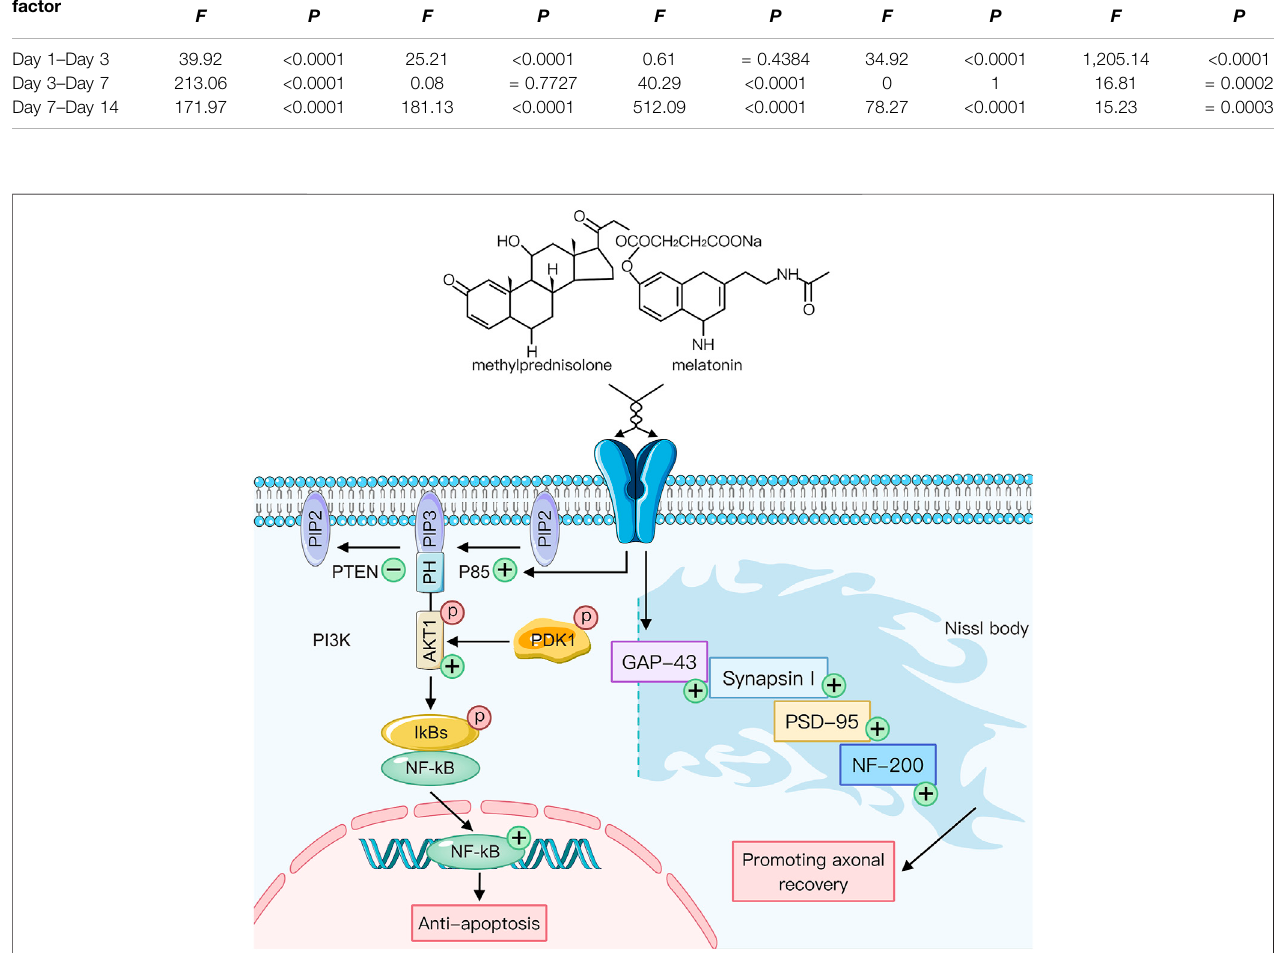
FIGURE 5 | The potential mechanism underlying the synergistic effect of melatonin and methylprednisolone in the stimulation ofkey axon proteins and inhibition of neuronal apoptosis. Expression. Arrows: the sequential direction, +: increase; − : decrease.